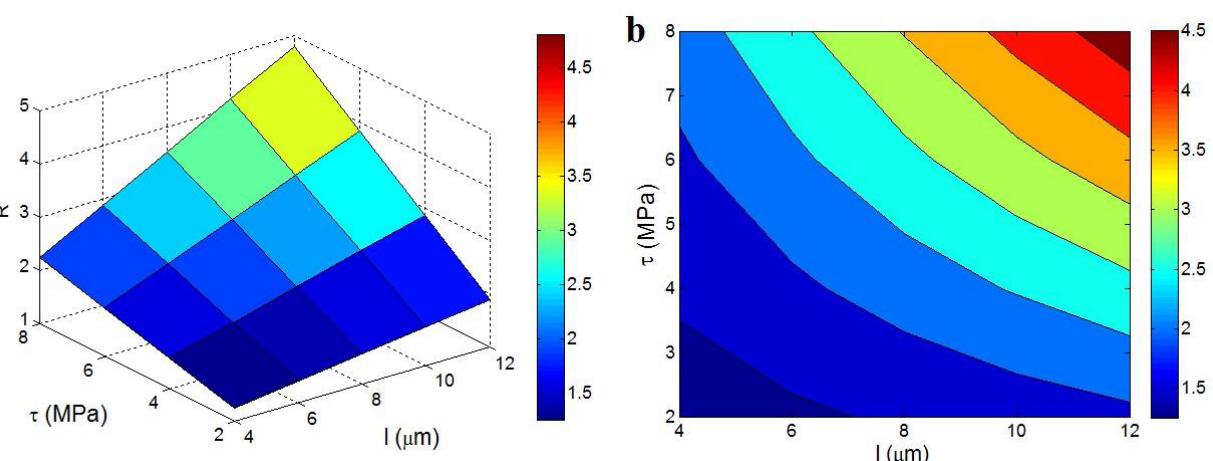
 = 0.02, R = 10 nm and t = 10 nm: